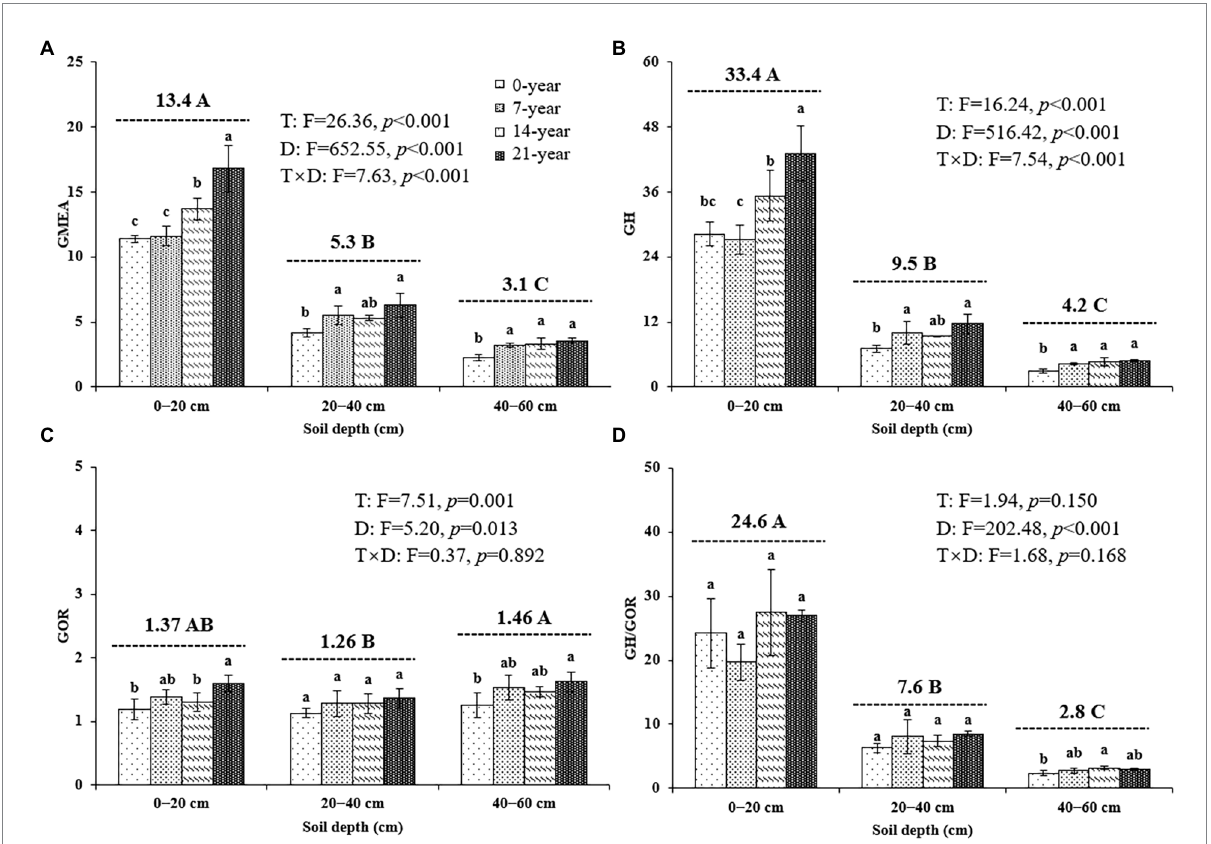
FIGURE 4 The geometric mean of the assayed extracellular enzyme activities ( (A) GMEA, (B) GH, (C) GOR, and (D) GH/GOR) at three soil depths (0–20, 20– 40, and 40–60 cm) under different ages of walnut plantations. Uppercase and lowercase letters represent significant differences ( p < 0.05) among different soil depths and different ages of walnut plantations in the same depths, respectively. Two-way ANOVA was applied for identifying the effects of walnut plantation ages, soil depths, and their interaction on the above indices (The data is shown in the upper right corner). GMEA, the geometric mean of seven extracellular enzyme activities; GH, the geometric mean of the hydrolase activities; GOR, the geometric mean of the oxidase